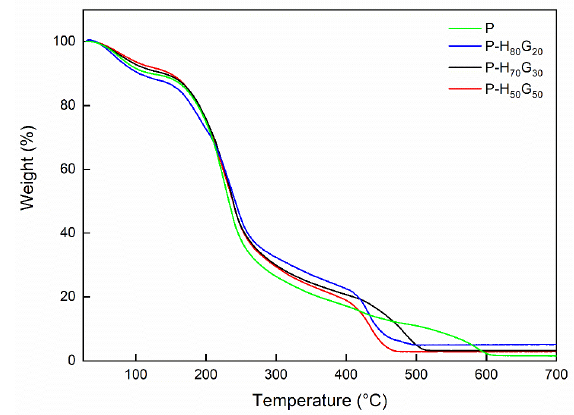
Figure 5. TGA curves of pectin and pectin composites.